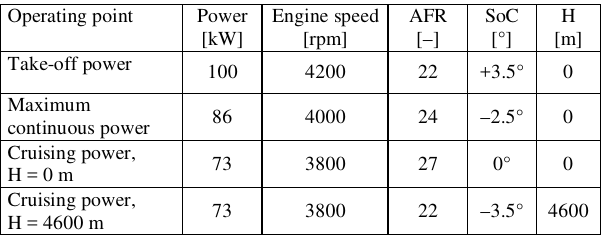
Table 2. Defined operating points for the variant with the Eaton TVS R900 mechanical compressor